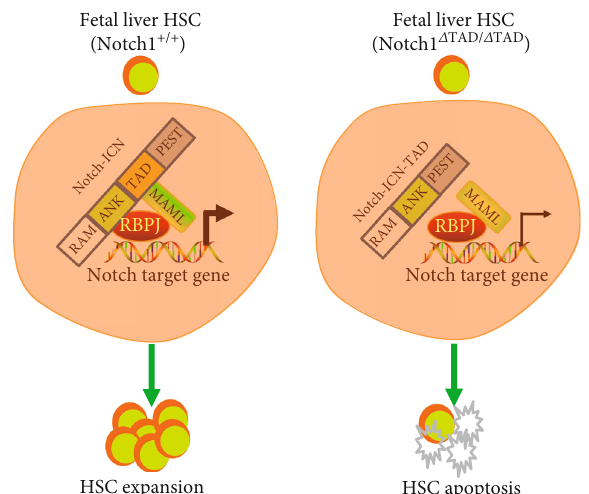
Figure 2: Notch1 transcriptional activation domain is essential for HSC expansion in the mouse fetal liver. Upon Notch1 activation, Notch1 intracellular domain (Notch1-ICN) gets into the nucleus forming complex with RBPJ and MAML, which increases expression of Notch1 downstream target genes and fetal HSC expansion. Loss of Notch1 transcriptional activation domain (Notch1 Δ TAD/ Δ TAD) leads to the failure of formation of Notch1-ICN/RBPJ/MAML transcription complex, which decreases the expression of Notch1 downstream target genes, resulting in HSC